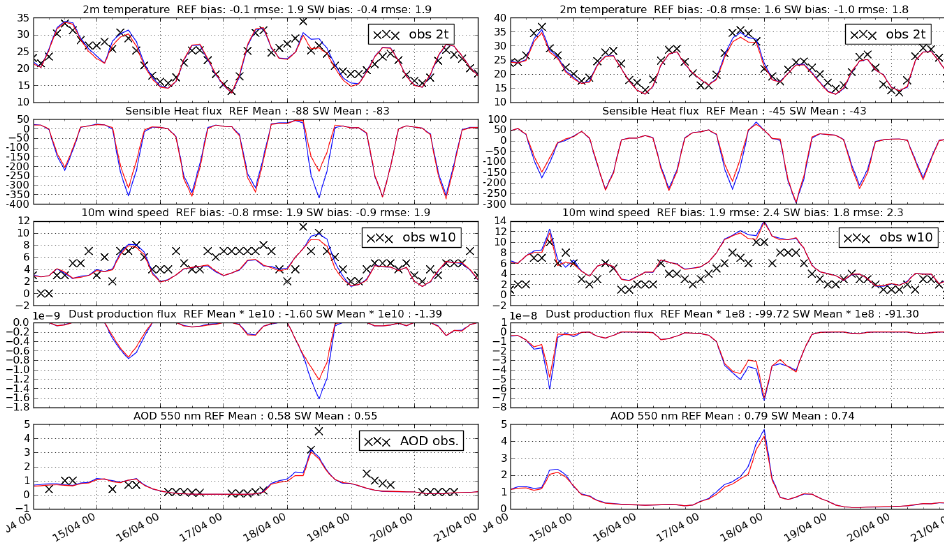
Figure 8. REF (blue) vs. SW (red) experiment, 3 to 24h forecasts and observations of 2m temperature (in ◦ C), sensible heat flux (in Wm − 2 ), 10m wind speed (in ms − 1 ), dust production flux (in kgm − 2 s − 1 ) and AOD at 550nm. Figures at Cairo are on the left panel and at Siwa Oasis on the right. For heat flux, negative values indicate that the surface warms the